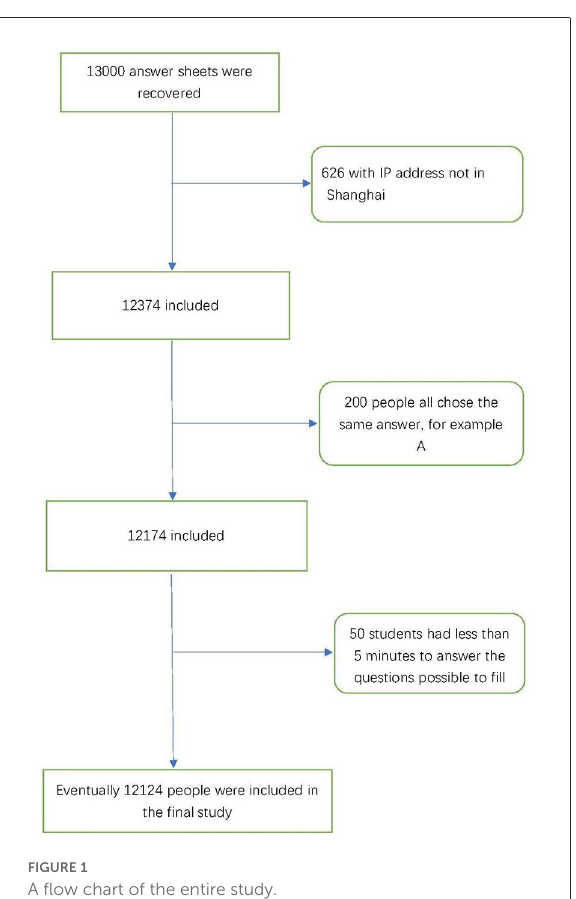
FIGURE1 A flow chart of the entire